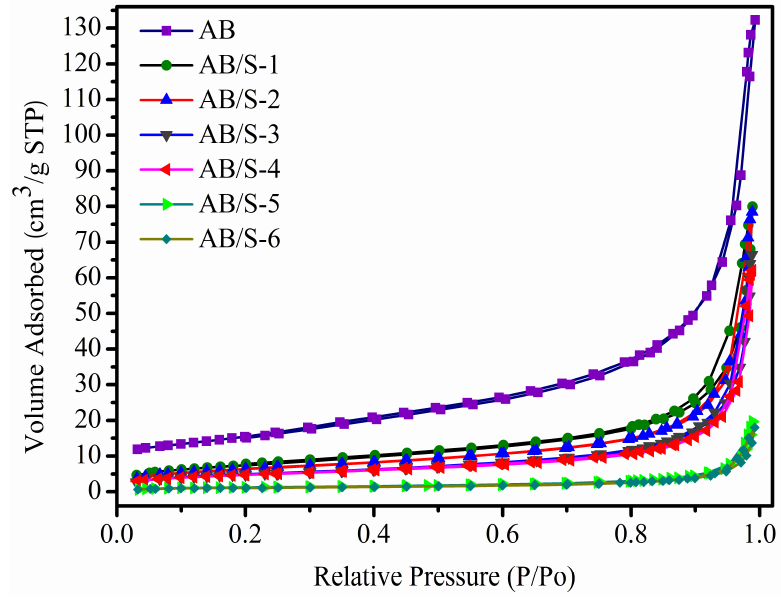
Figure 4. Adsorption isotherms of AB and the composite materials.